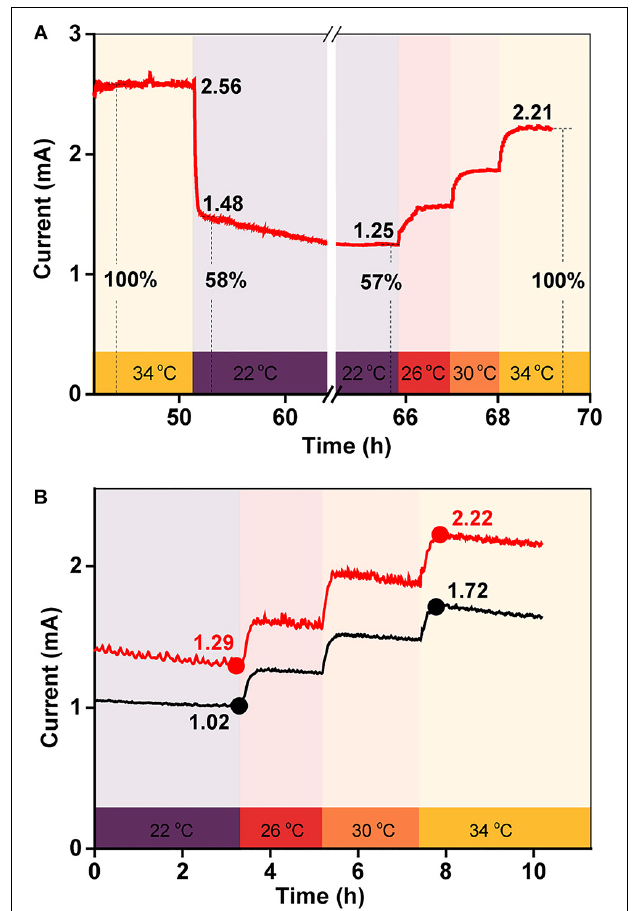
FIGURE 3 | (A) Current generation in a BES when the temperature was quickly decreased from 34 to 22 ◦ C, and then gradually increased back to 34 ◦ C over 3 h; (B) replicates of (A)